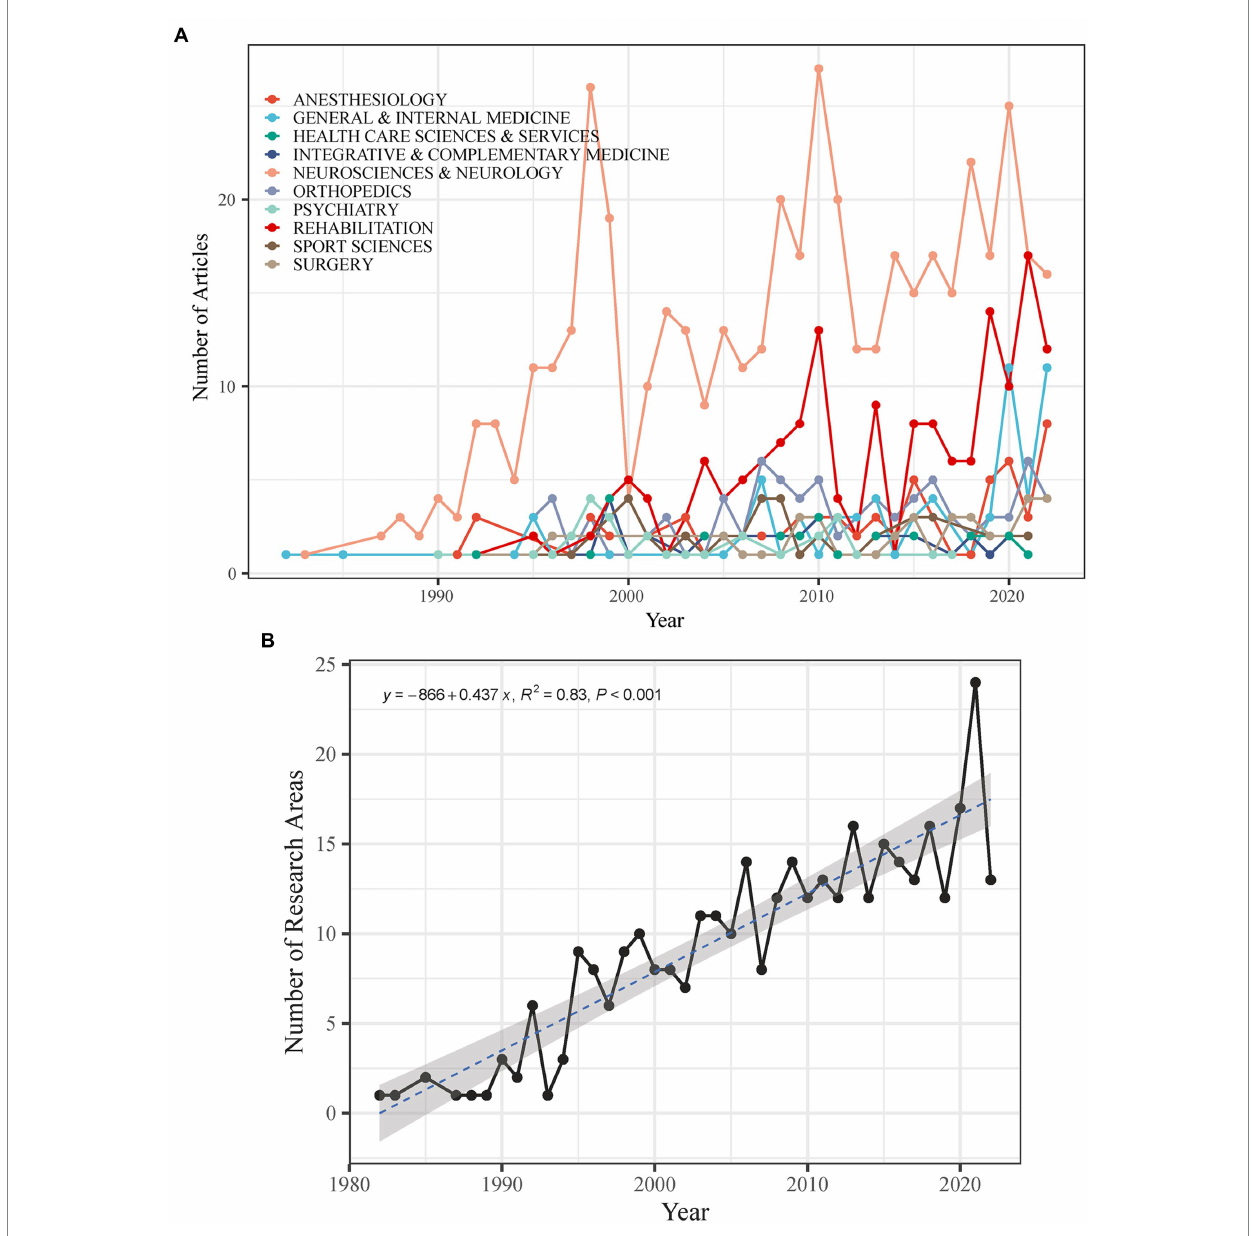
FIGURE 3 (A) Number of research areas in the CEH-related literature. (B) Temporal evolution of the top 10 most fecund research areas in the CEH-related